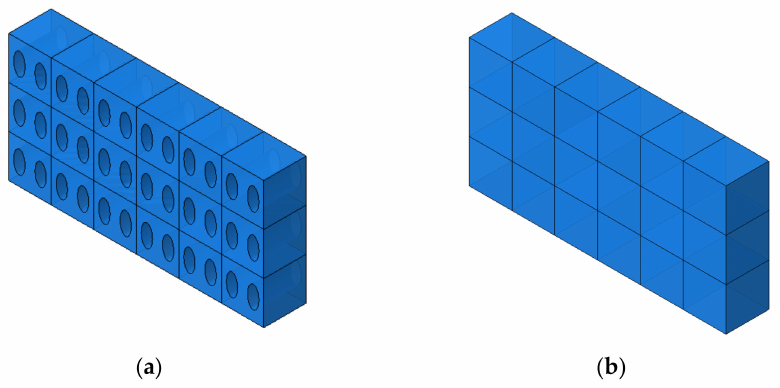
Figure 1. ( a ) Shape of unit cell before homogenization. ( b ) Shape of unit cell after homogenization. The related governing equations are shown as Equations (1)–(5) below [9–12]. Equa- tion (1) means that the strain energy before and after homogenization is the same.